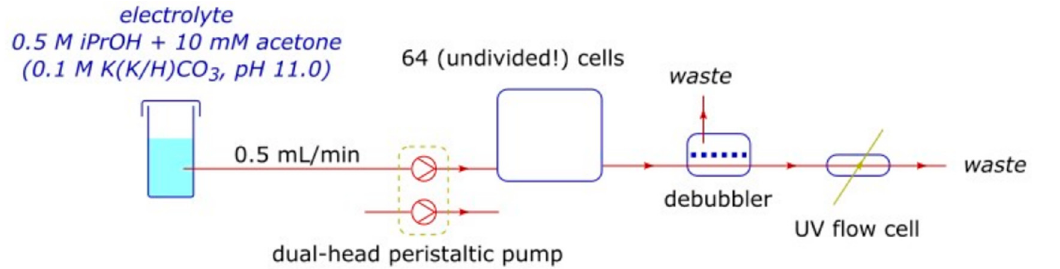
Figure 4. Experimental setup for the alcohol oxidation experiments.